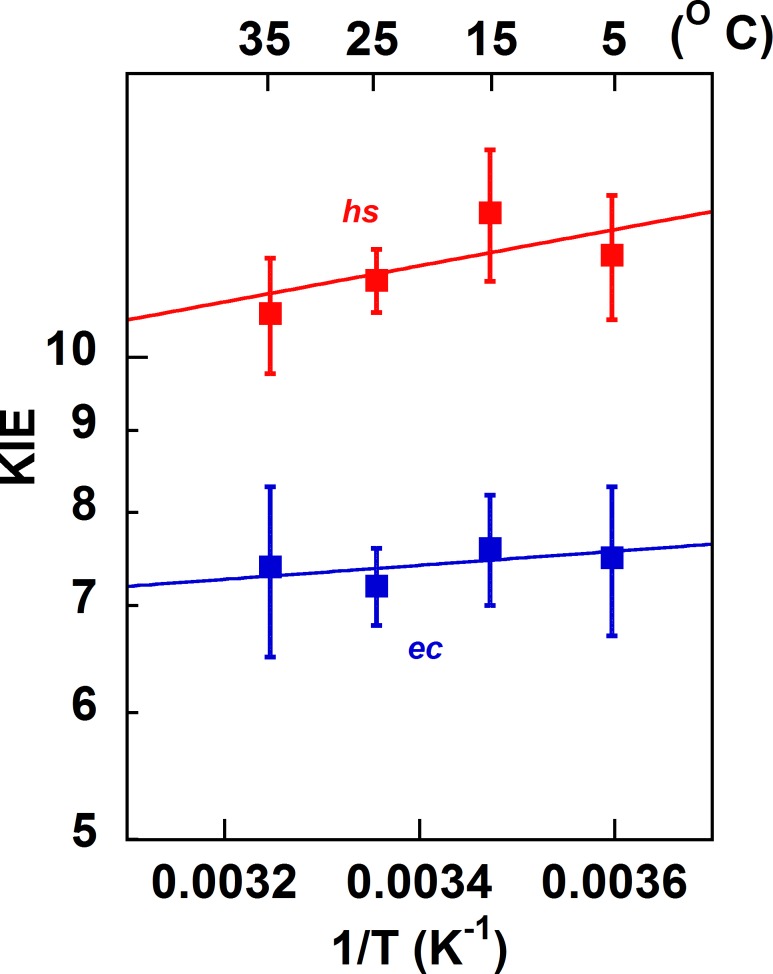
Arrhenius plot of KIEints for hydride transfer.The lines are from regression to Eq 4 for ecTSase (blue) [8] and hsTSase (red).